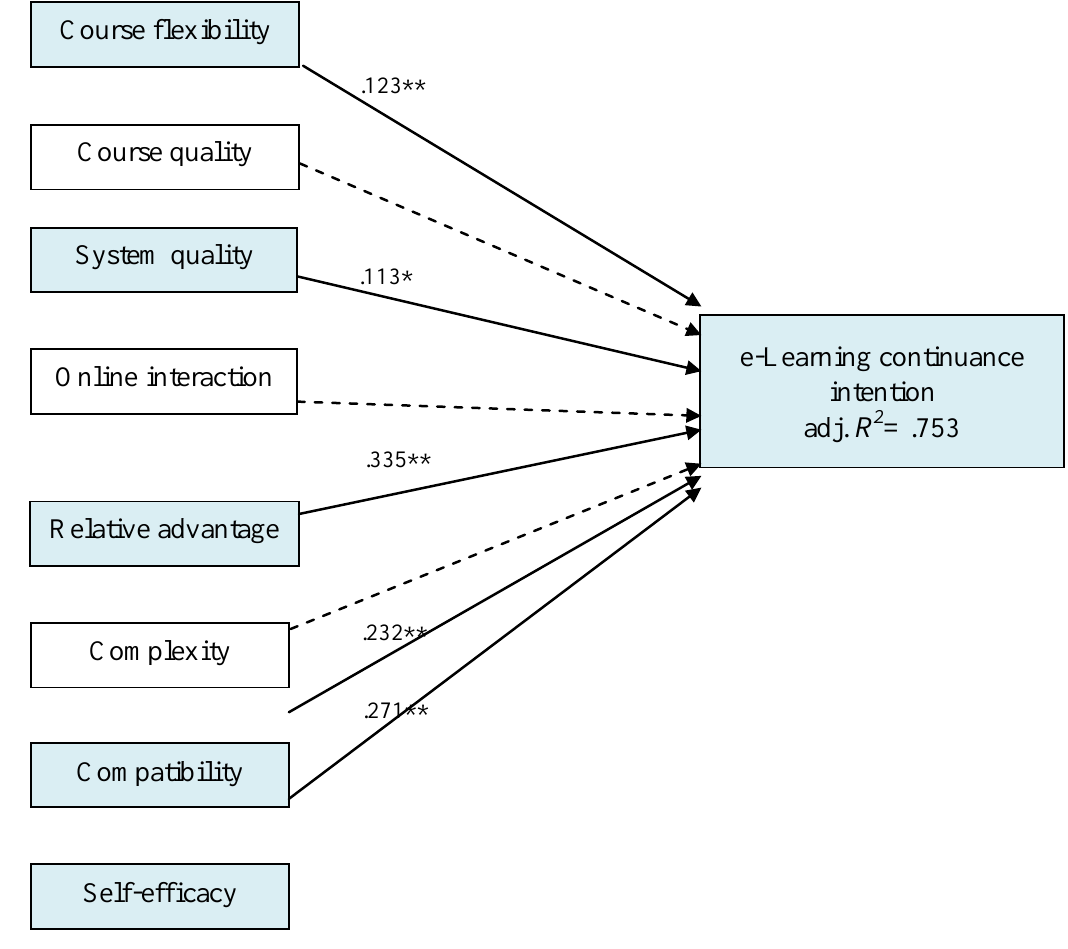
Figure 3. Model of factors affecting learners' e-learning continuance intention for the low- degree-of-participation group. Note: Solid lines represent significant results, whereas dotted lines represent insignificant results; * p < .05, ** p <